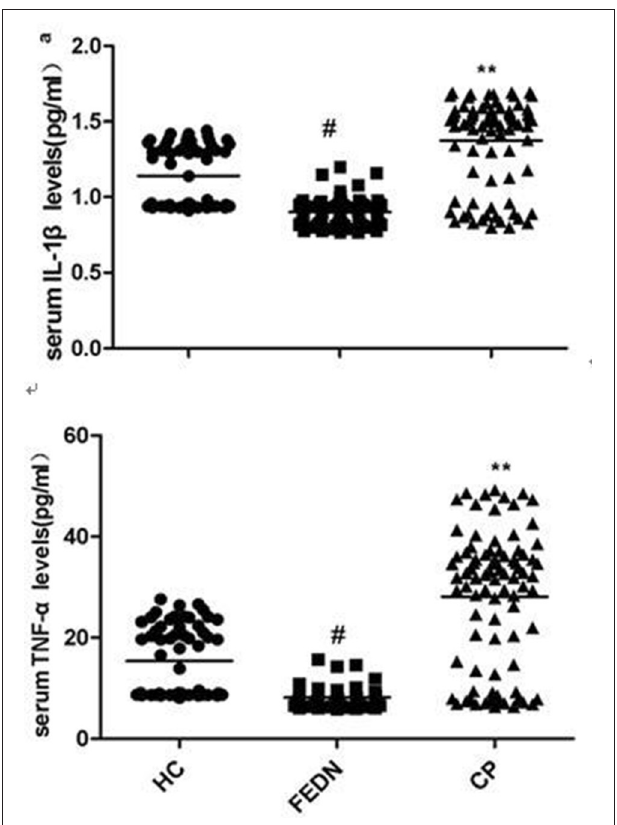
FIGURE 1 | Serum TNF- α or IL-1 β levels in FEDN ( n = 69), CP ( n = 87) and HC ( n =